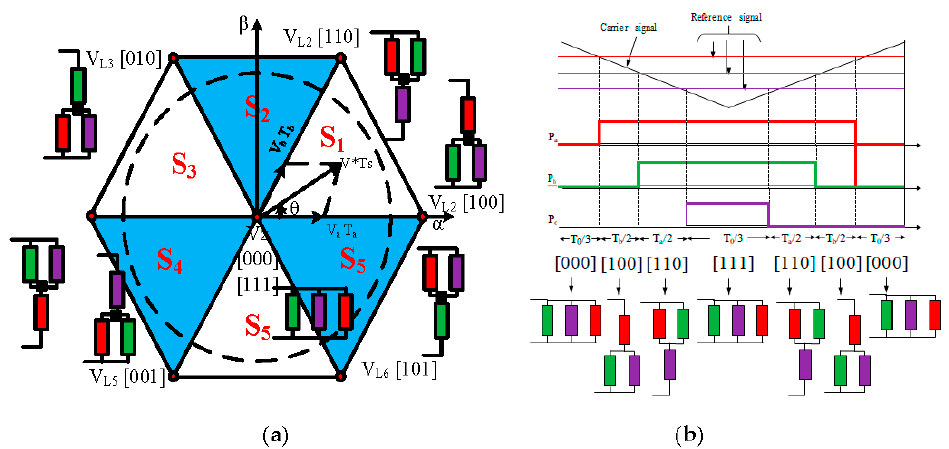
Figure 5. Space vector diagram switching state and respective switching pulse. ( a ). Space vector diagram switching state, ( b ) respective switching pulse for sector − 1 The ‐ plane projection of V* during any period lies in any one of the sector areas.